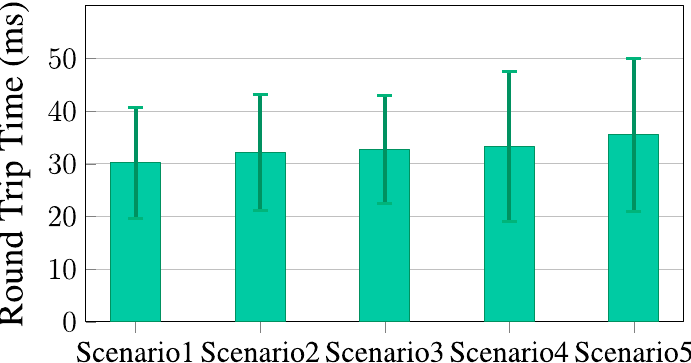
Figure 9. Average Round Time Trip (RTT) between H1 and H6 during attacks.